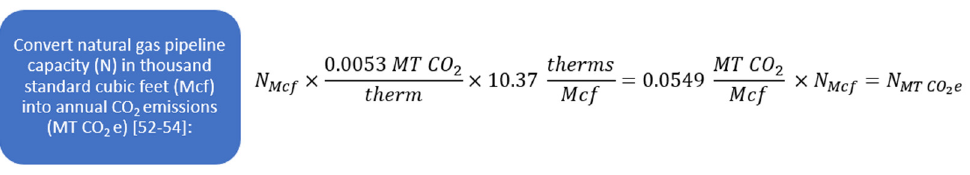
Figure 2. Stepwise process used to calculate potential annual CO 2 emissions (MT CO 2 e) of an oil facility.